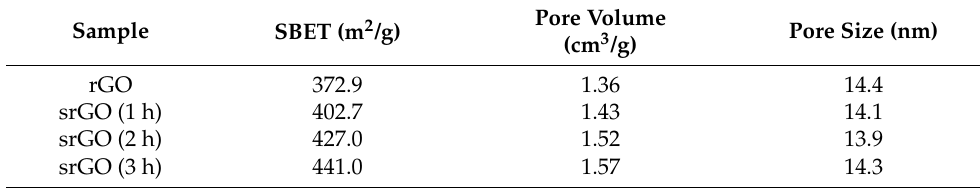
Figure 2. FE-SEM and TEM images of ( a , e ) rGO, ( b , f ) srGO (1 h), ( c , g ) srGO (2 h), and ( d , h ) srGO (3 h). Table 1. BET surface area, pore volume, and pore size of rGO and